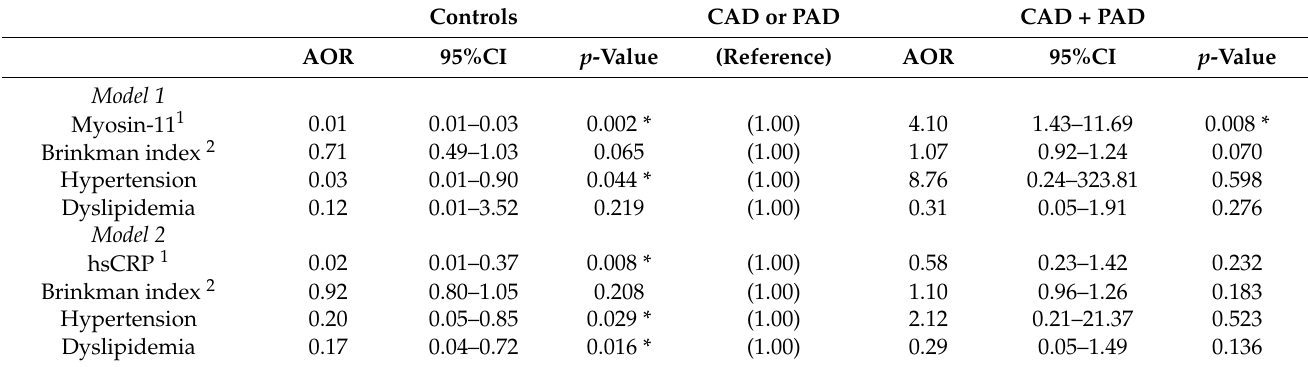
Table 3. Association between standardized score of myosin-11/hsCRP and